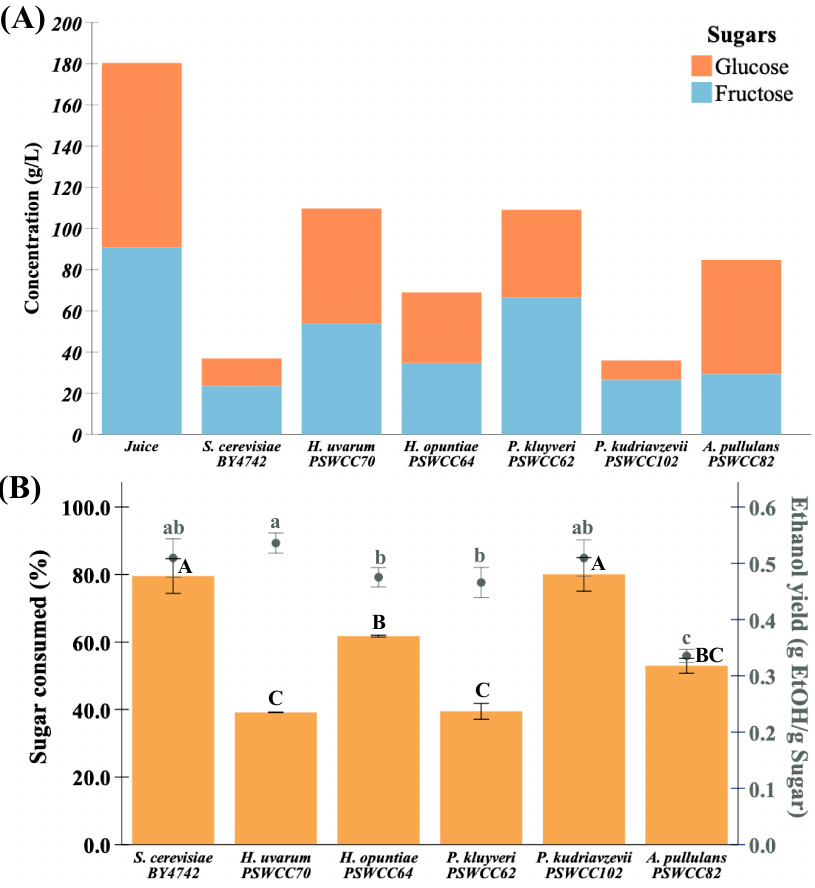
Figure 4. Composition of major sugars, sugar consumed, and ethanol yield in sterile juice compared to inoculated fermentations with candidate non- Saccharomyces yeast strains measured by UHPLC analysis. ( A ) Glucose (blue) and fructose (orange) represent major sugars in grape juice and wine. ( B ) Percent sugar consumed and ethanol yield during fermentation. Circles represent ethanol yield measured at the end of fermentation. Different types of yeasts used in this study are represented on the x-axis. Data presented as mean ratio ± SEM with a common superscript indicating significance ( p < 0.05). Strains used in this study are represented on the x-axis, S. cerevisiae BY4742 was used as a control.